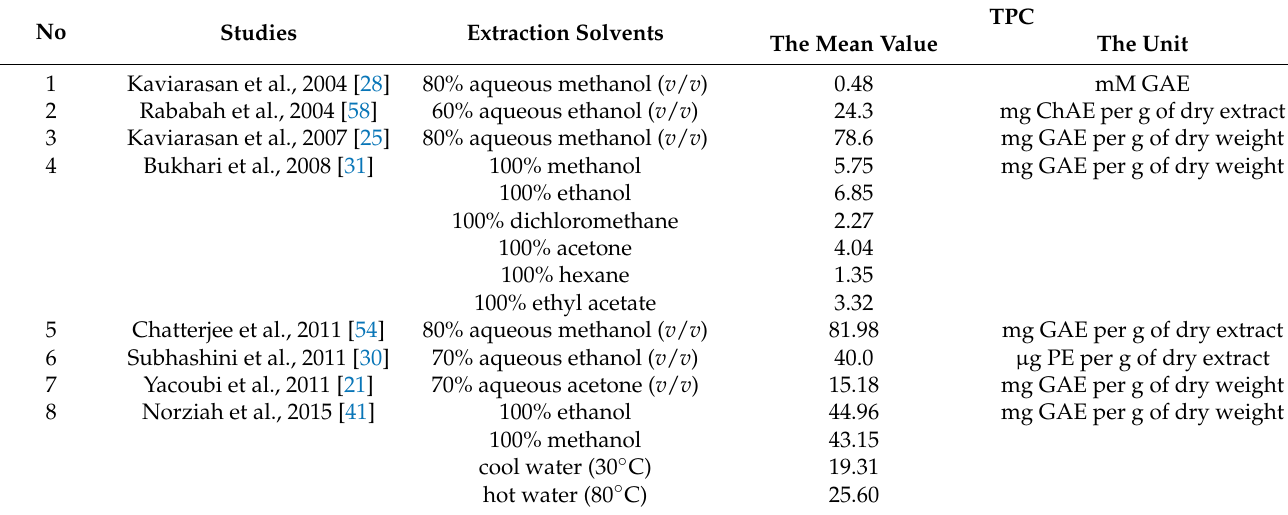
Table 1. TPC in fenugreek seeds that reported in the previous studies.